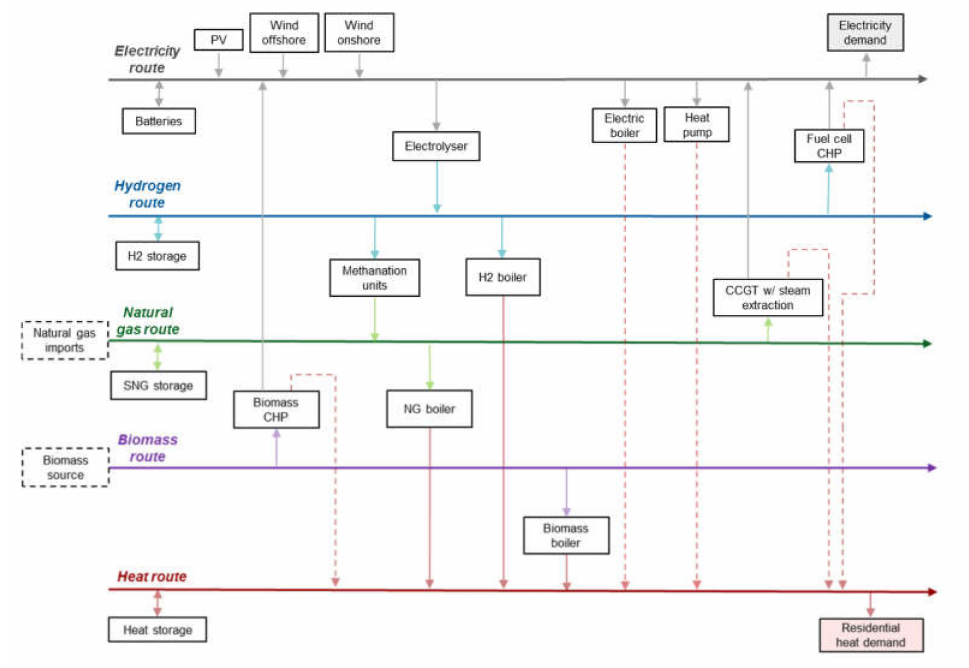
Figure 1. Schematic description of the multi-energy